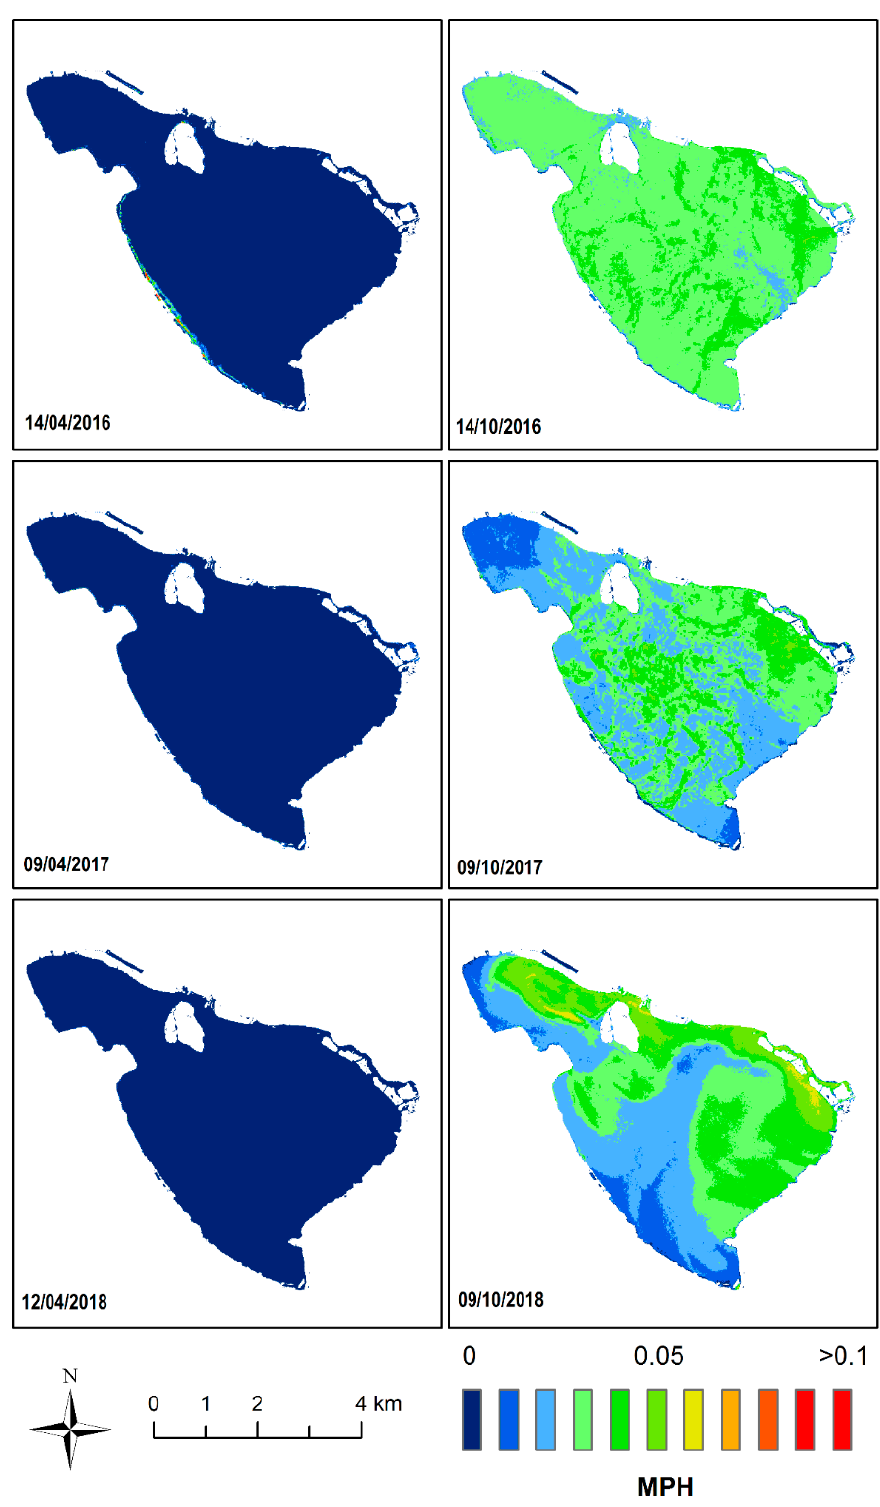
Figure 4. The MPH index during active and inactive periods in Pamvotis lake. The index is dimensionless.